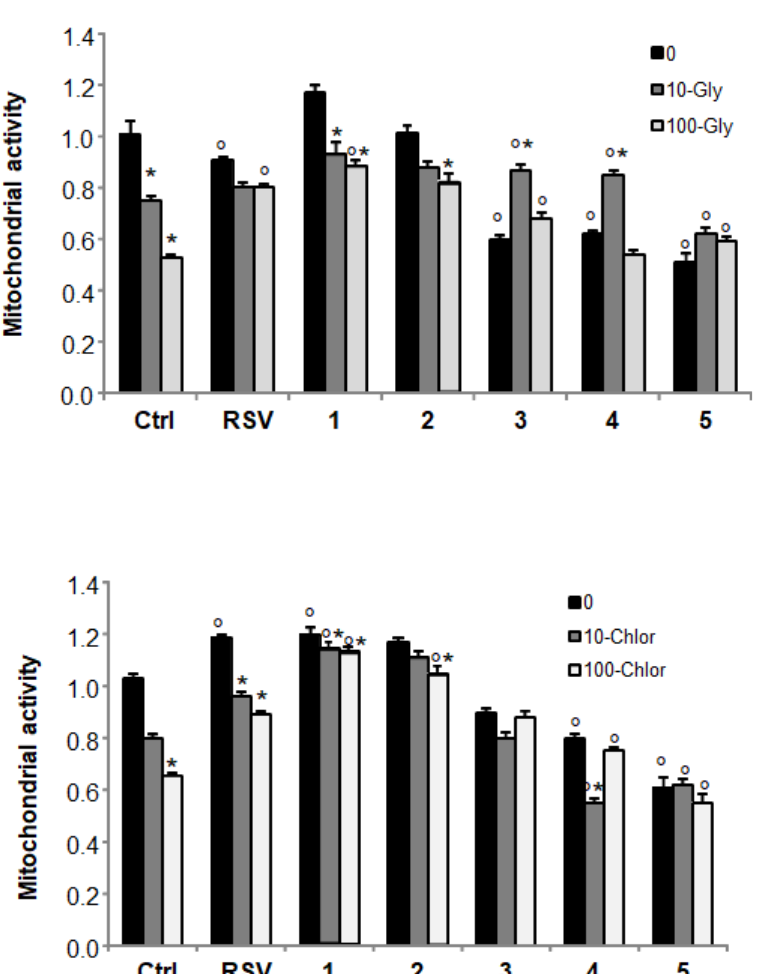
Figure 5. Effects of compounds 1 – 5 on mitochondrial activity (RSV = resveratrol) (* Significance non-treated vs. chlorpyrifos or glyphosate + compounds under investigation; ° Significance Ctrl vs compounds).